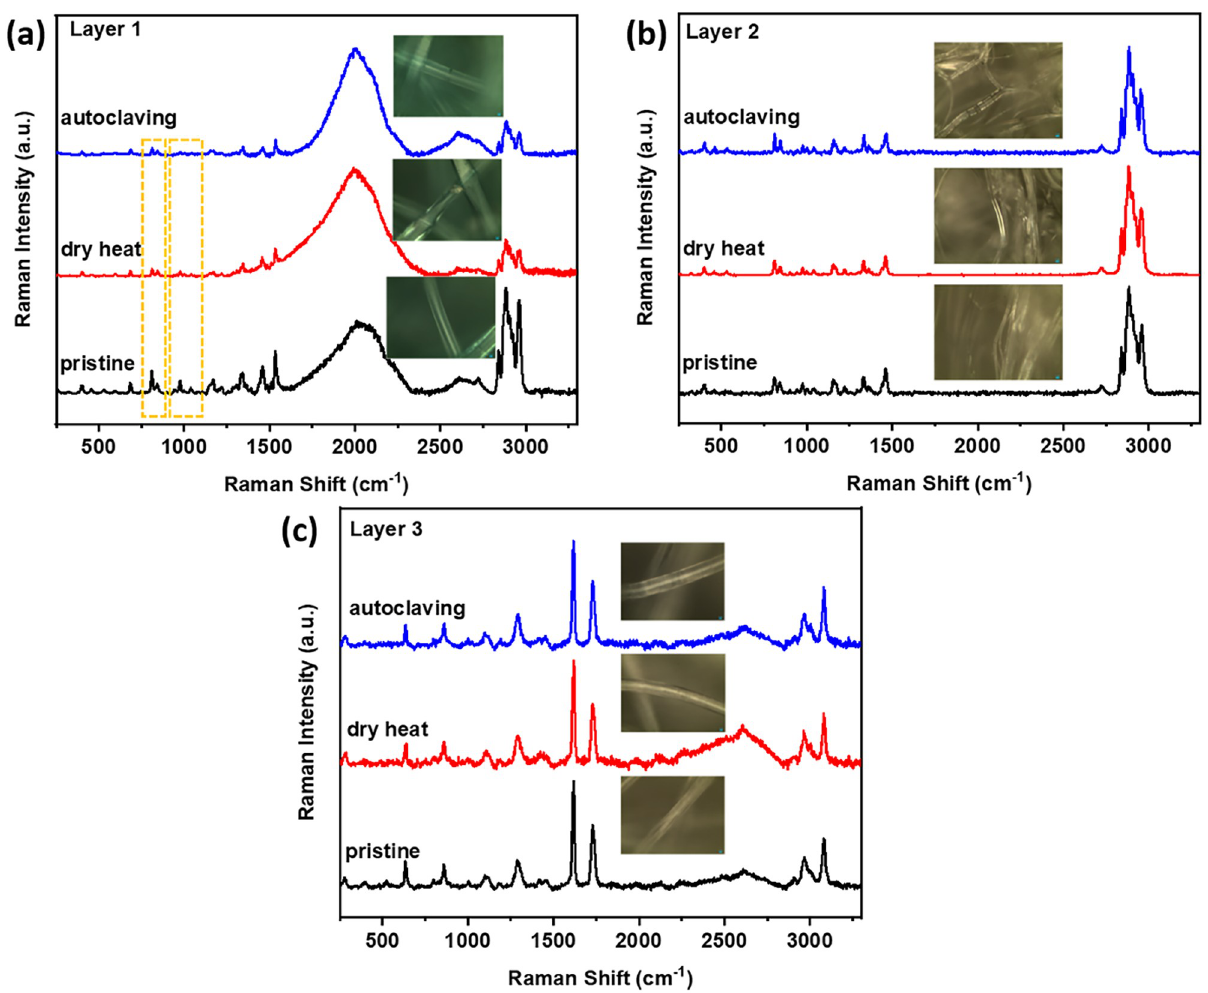
Fig 4. Raman spectra of three layers in 3M 1860 N95 FFR material. Spectra before dry heat, after dry heat, and autoclave heat treatment for the respective layers.